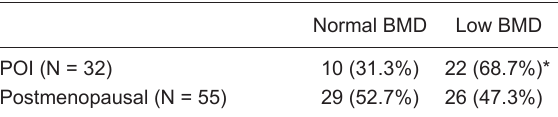
Table 4. Prevalence of low bone mineral density in the primary ovarian insufficiency and postmenopausal reference